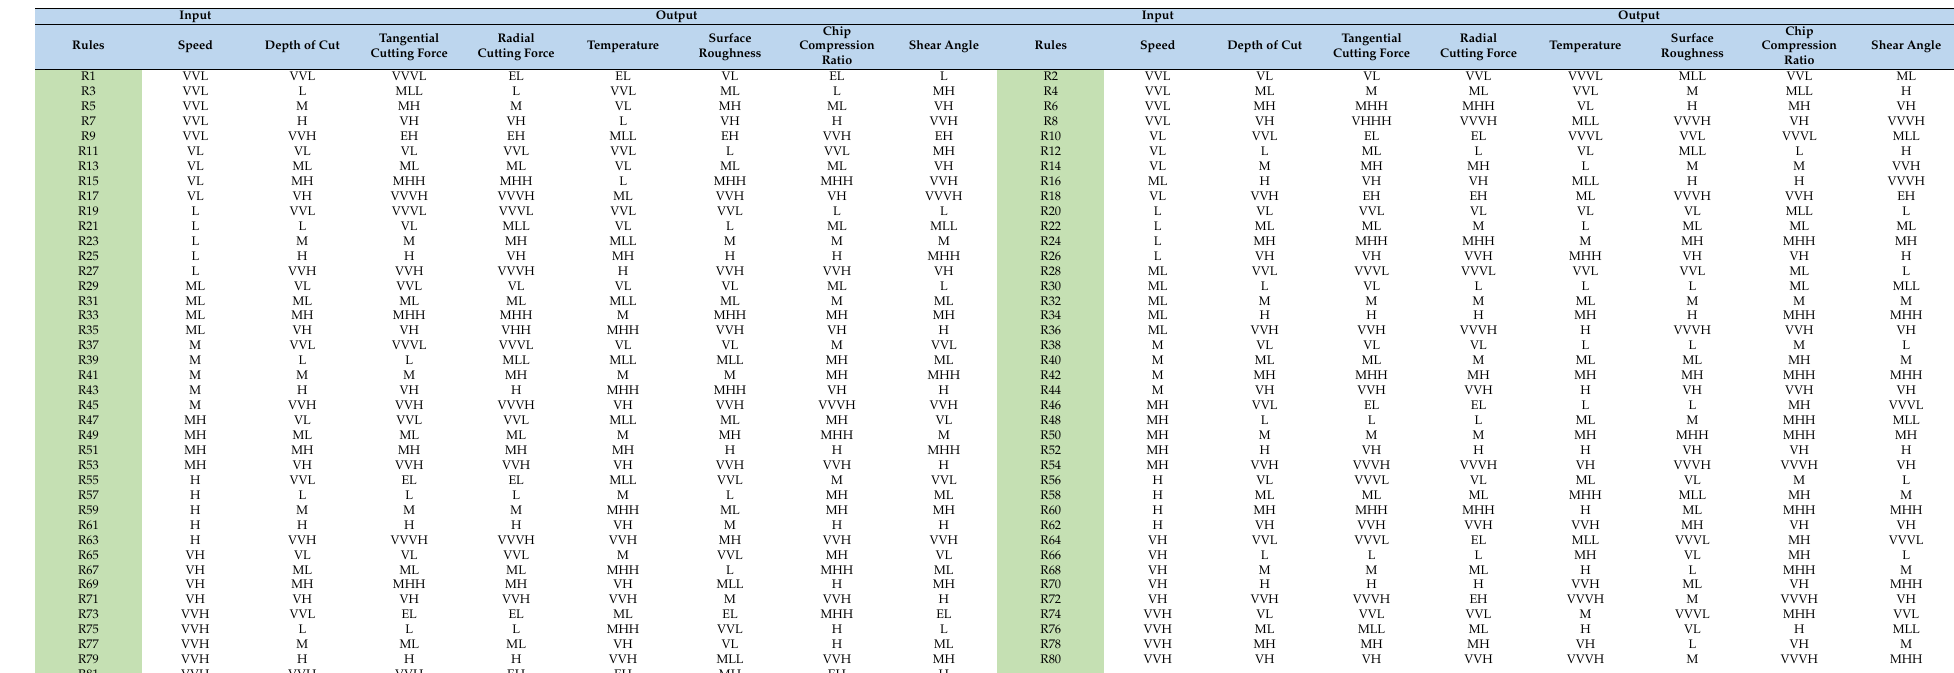
Table 5. The rules defined for the CT fuzzy inference